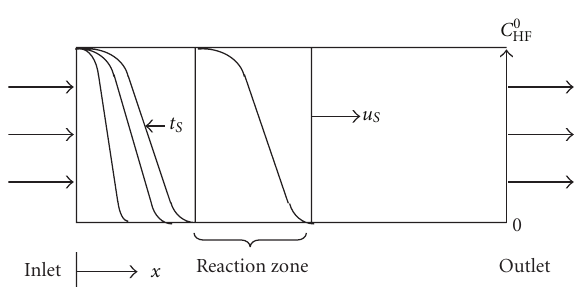
Figure 4: Inside phenomenon on the fixed-bed furnace.